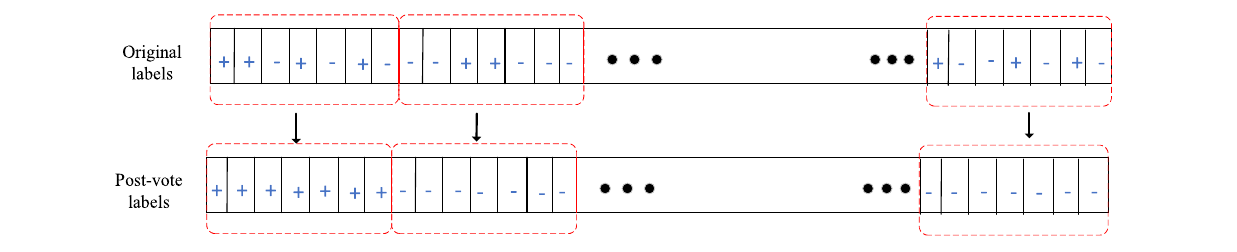
FIGURE3 Majority voting diagram.